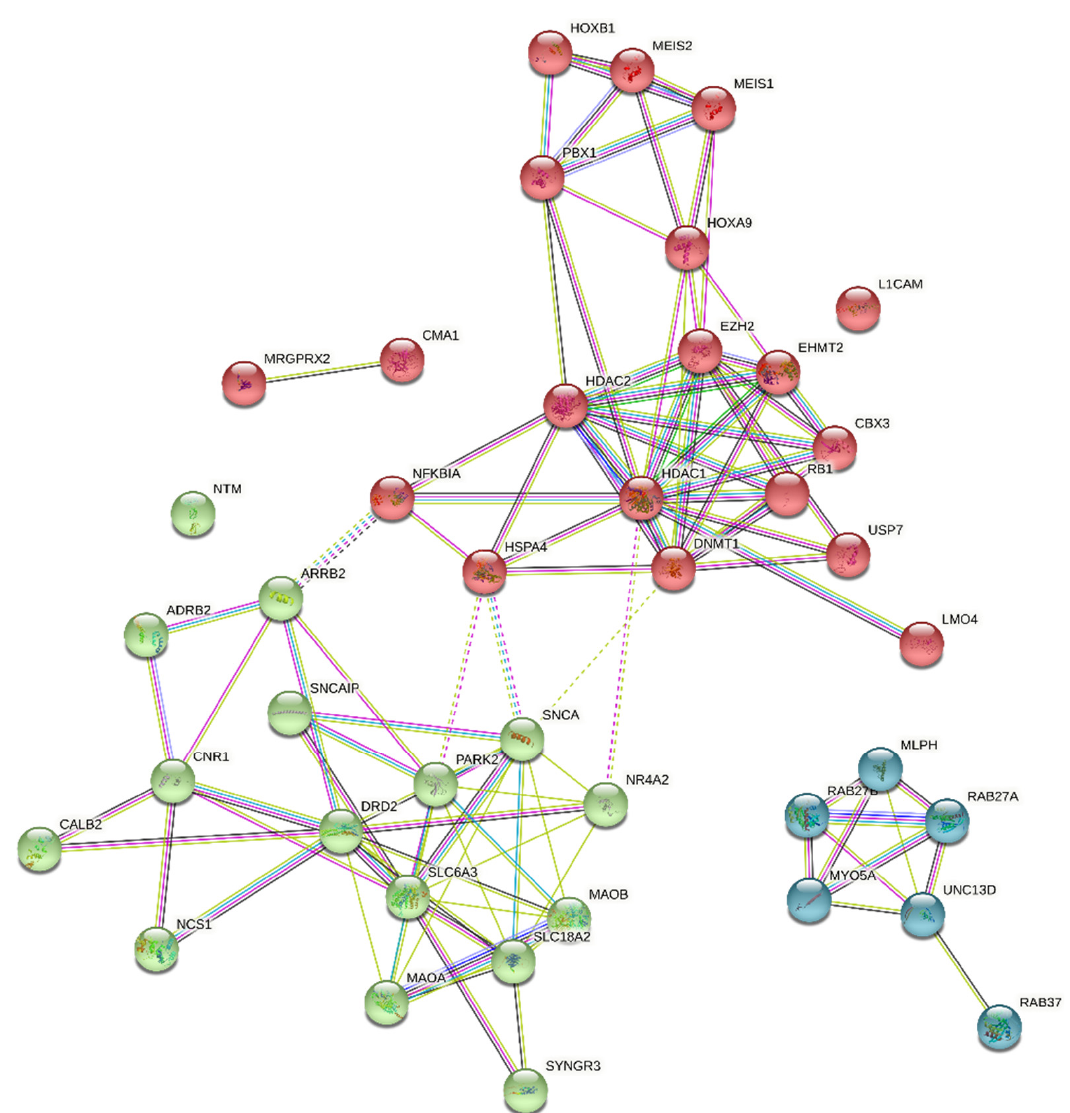
Figure 6. Protein–protein interaction network from the String Database. To predict the functional interactions of selected neuronal genes with other genes transcribed in MCs, a network analysis was performed using the STRING database (https://string-db.org) [242]. Up to the fourth step, additional nodes were added to the basal model until interconnectivity was achieved. The final network is displayed as a specified number (kmeans = 3) of clusters according to its topological properties, with each cluster highlighted in a different color.